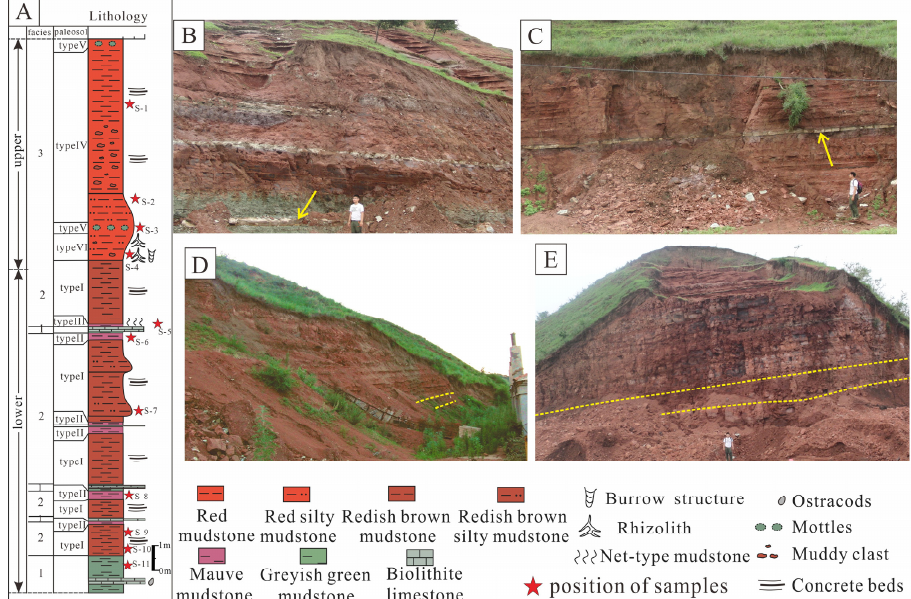
Figure 2. Measured section of the K 2 y 1 in outcrops. ( A ) Sedimentary column of sections containing different types of facies and paleosols. ( B , C ) Overall characteristics of facies 1 and facies 2 in the lower part of the section with an ostracod layer marked by an arrow. ( D , E ) Overall characteristics of facies 3 in the upper part of the section; the rhizoliths are marked with yellow dotted lines (modified after [38] ).